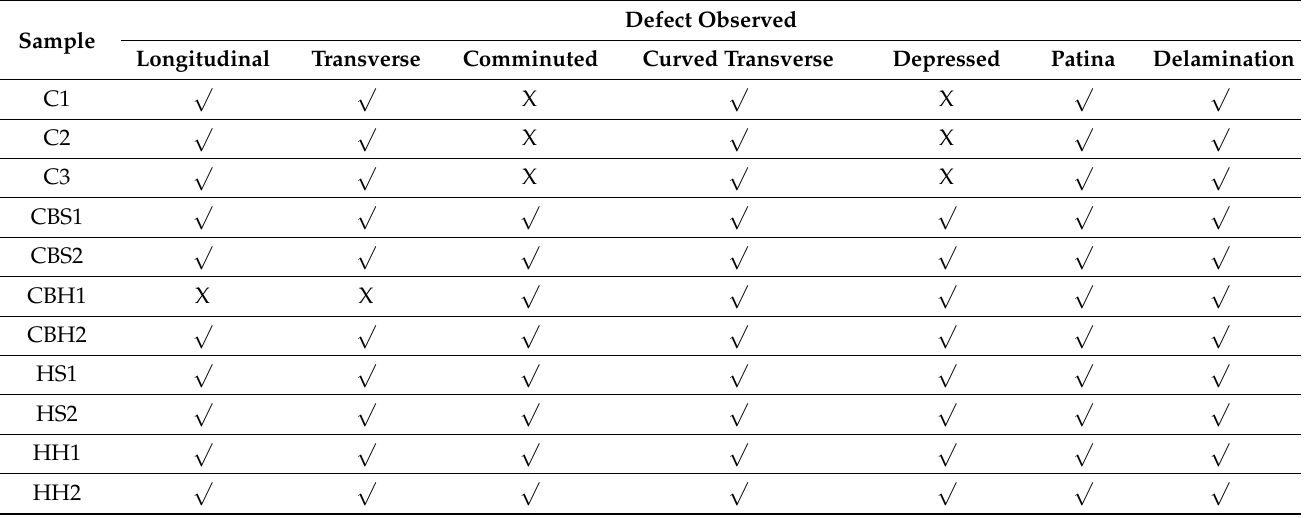
Table 2. Summary of fracture pattern observations. absence of